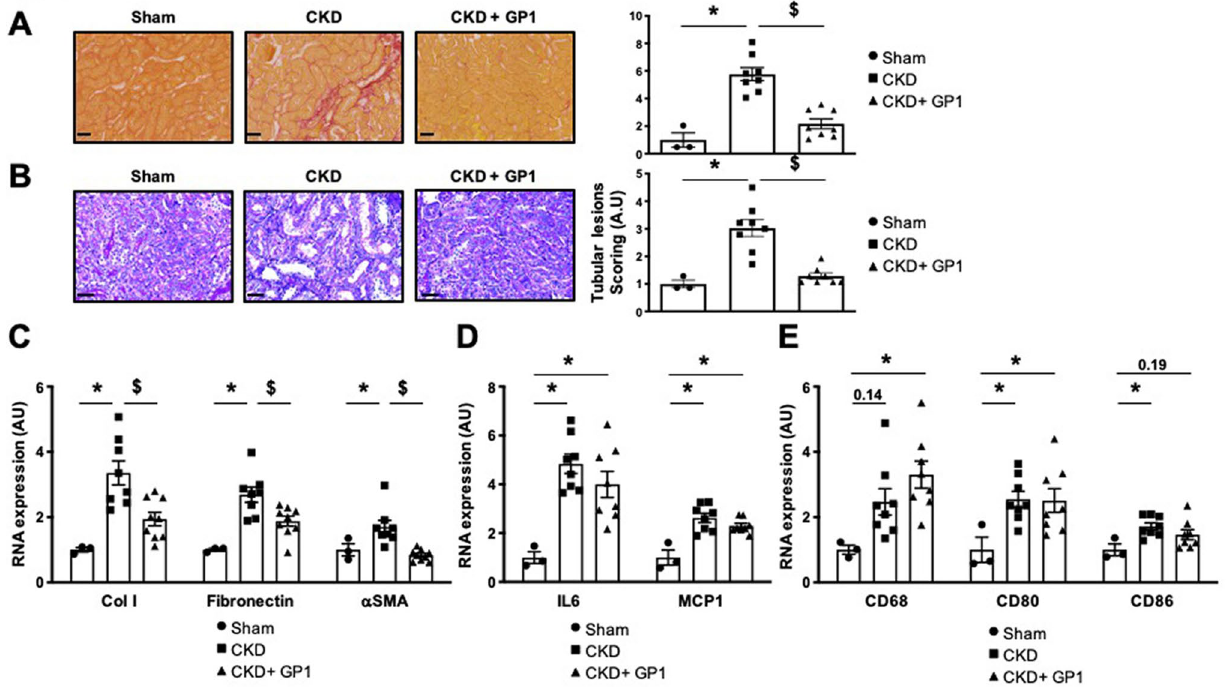
Figure 4. Effect of two months of GP1 (GPZ614741) administration. ( A ) Representative microphotographs and quantification of Sirius red staining and ( B ) Periodic acid-Schiff staining (scale bar 50 μm), and ( C ) mRNA expression of profibrotic markers (Col I, fibronectin and αSMA), ( D ) proinflammatory markers (IL6 and MCP1), and ( E ) CD68, CD80, and CD86 in a CKD mouse model. *p < 0.05 vs . Sham. † p < 0.05 vs. CKD